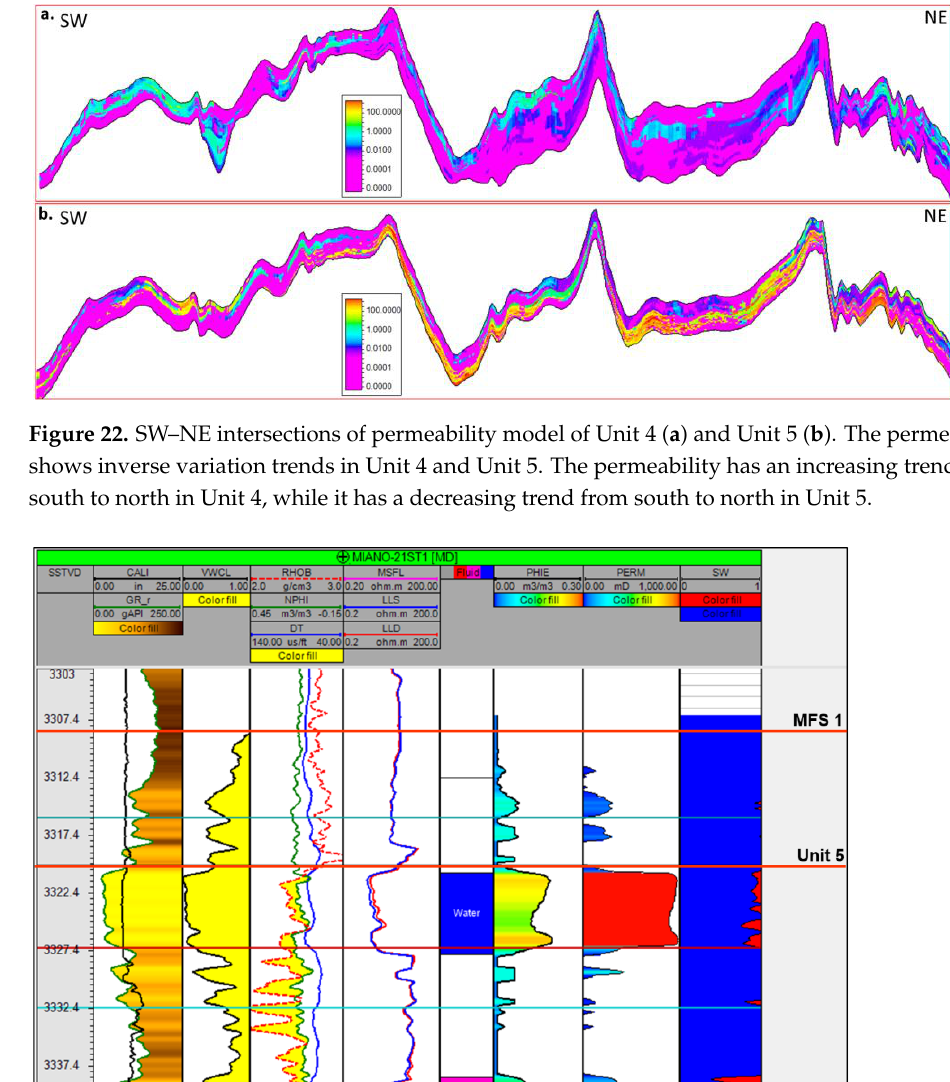
Figure 21. The permeability models of Unit 4 ( a ) and Unit 5 ( b ). The permeability model presents inverse variation trends. The southern part has higher permeability in Unit 4, while the northern part tends to be more permeable in Unit 4.